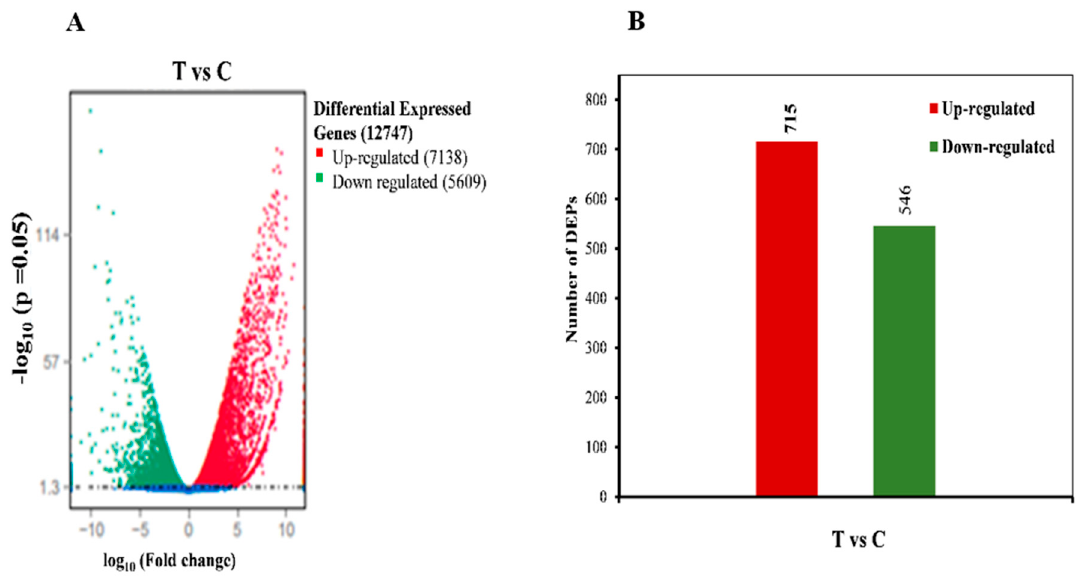
Figure 2. ( A ) Expression pattern of di ff erentially expressed genes in treated and control samples. The di ff erential genes are shown in red and green colors. ( B ) Quantification of di ff erentially expressed proteinsintreated(T)andcontrolledbudsamples. Numberofup-anddown-regulatedwererepresented in colored bars. A quantitative ratio over 2 was considered up-regulation while a quantitative ratio less than 0.5 was considered as down-regulation ( p <